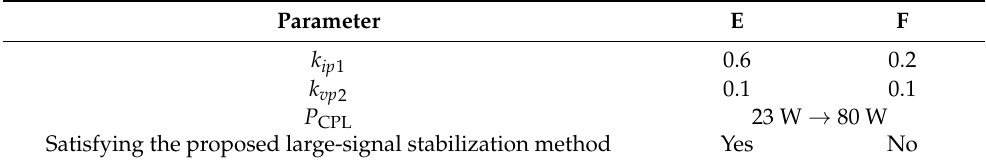
Table 6. Experimental parameters of Groups E and